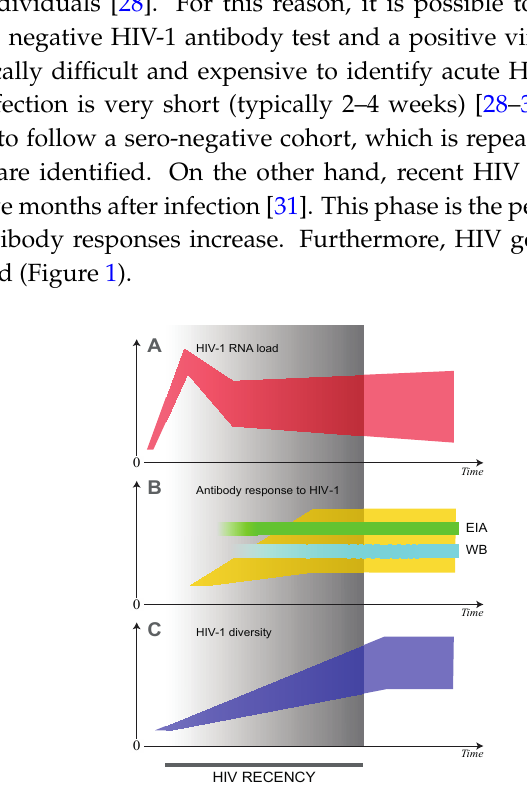
Figure 1. Markers of HIV recency: HIV-1 RNA load ( A ); antibody response to HIV-1 ( B ); and HIV-1 diversity ( C ). Heterogeneity of presented markers among HIV-infected individuals is highlighted by polygons (instead of single curves): red for HIV-1 RNA, yellow for cumulative anti-HIV antibodies, and blue for virus diversity. Time 0 indicates time of HIV transmission. The end of HIV recency period corresponds to approximately 12 months after HIV transmission. EIA: Enzyme immunoassay test for anti-HIV antibodies; WB: Western Blot.